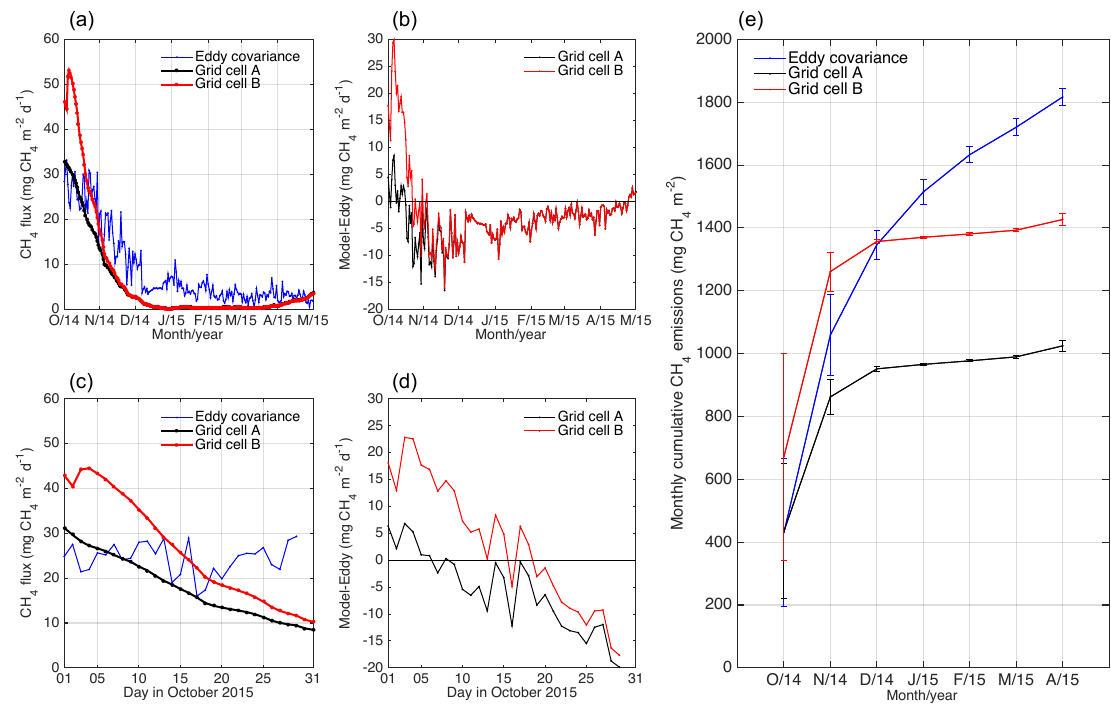
Figure 10. Mean daily ancillary variables and CH 4 emissions in the model domain in 2014 and 2015: (a) total CH 4 emissions, (b) mean soil temperature in the root zone (top five soil layers), (c) domain mean relative soil moisture content in the top five soil layers, (d) domain mean relative soil ice content in the top five soil layers, and (e) inundated fraction of the grid cell.